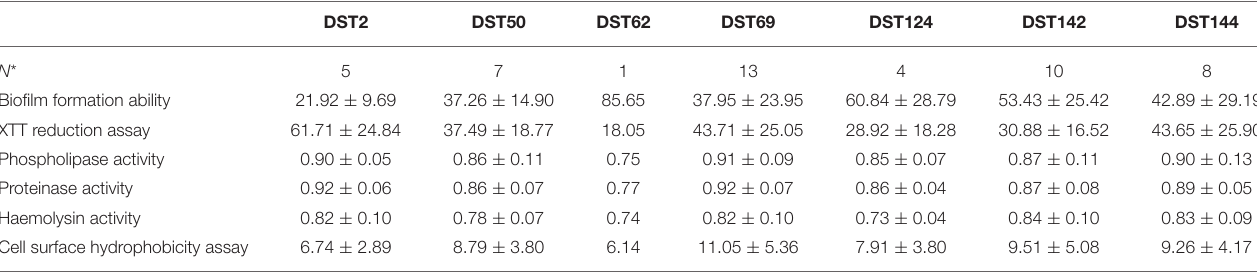
TABLE 3 | The relation between the different diploid sequence types (DST) and biofilm formation ability, XTT reduction assay, and activities of phospholipase, proteinase, and hemolysin and cell surface hydrophobicity assay (Mean ± Standard Deviation). DST2 DST50